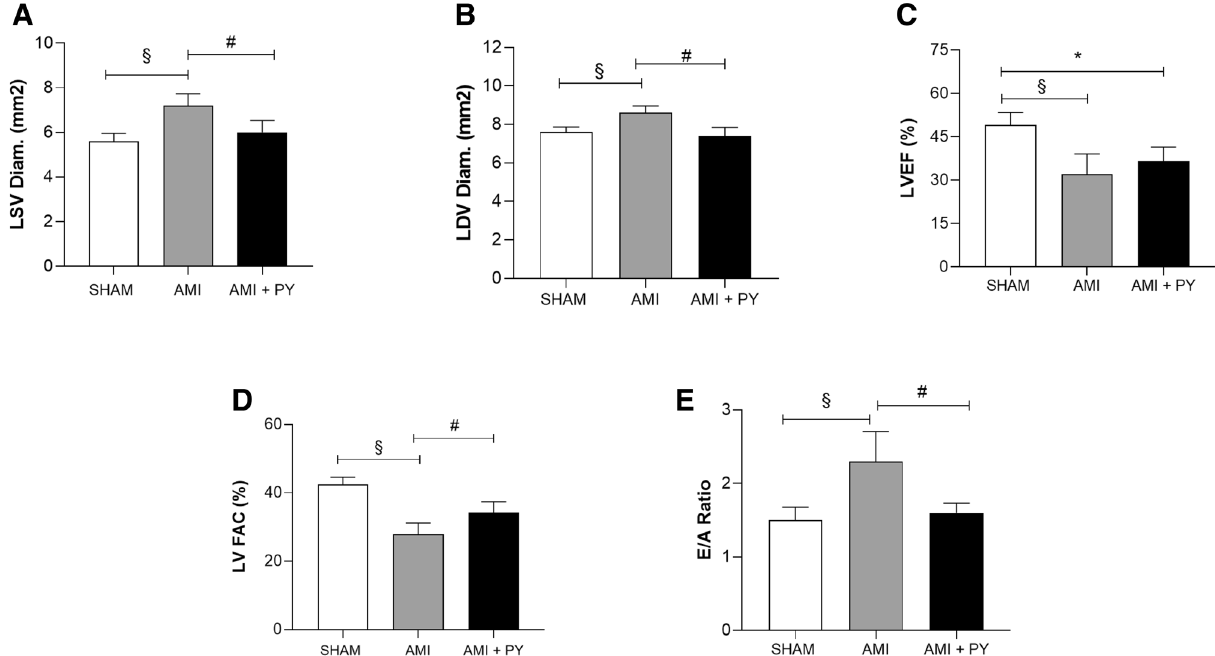
Figure 3. EchoDopplercardiographic parameters. ( A ) LSV Diam. And ( B ) LDV Diam.: left systolic and diastolic ventricular diameters, respectively. ( C ) LVEF: left ventricular ejection fraction ( D ) LV FAC: global left ventricular systolic function estimated by the FAC: fractional area change and ( E ) E/A: transmitral flow/E/A ratio. * P < 0.05 versus Sham; # P < 0.05 versus AMI; § P < 0.05 Sham versus AMI. Values expressed as mean ±